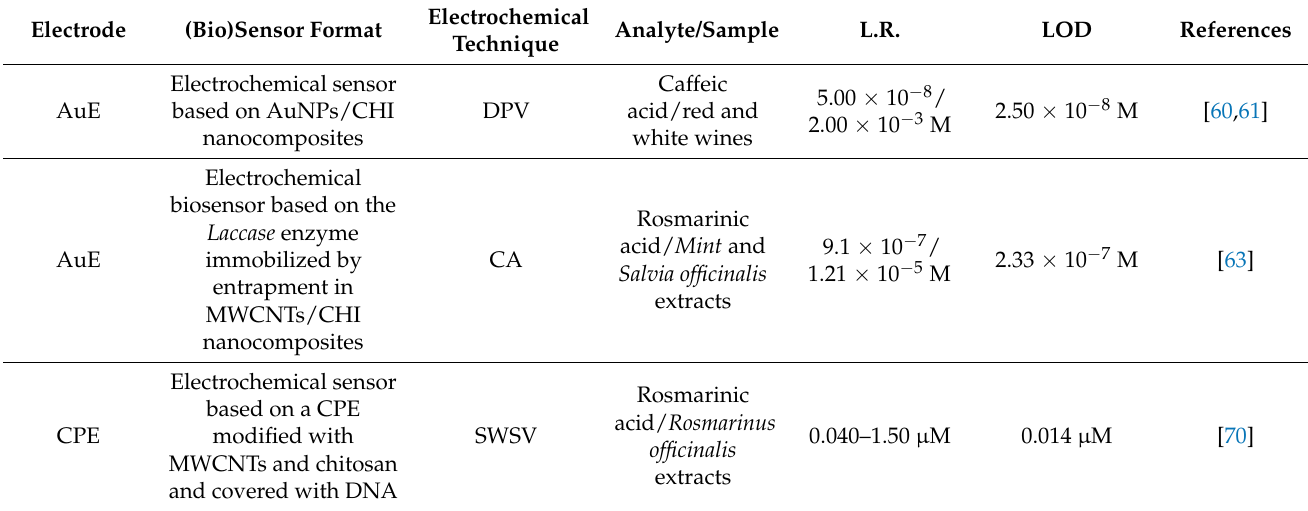
Table 1. Recent examples of CHI-based electrochemical sensors for hydroxycinnamic acids (HAs) detection.